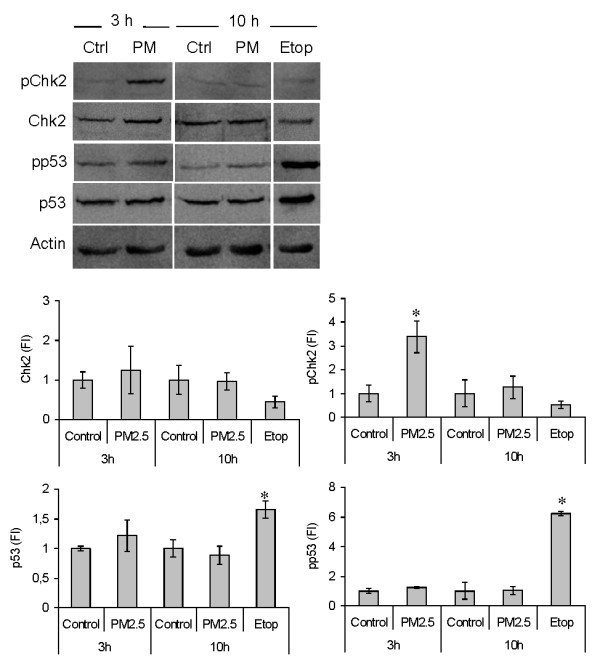
Cell cycle control proteins expression. The expression of p53/pp53 and Chk2/pChk2, proteins possibly involved in G2 checkpoint, was measured by Western blotting in BEAS-2B cells exposed for 3 and 10 h to 7.5 μg/cm2 of winter PM2.5. The topoisomerase II inhibitor etoposide (Etop, 250 nM, 10 h exposure) was used as positive control for p53/pp53. Representative images of the Western blotting are shown and the results of 3 independent experiments are reported in the histograms as fold increase (FI) over the control values (mean ± SEM). *Statistically significant difference from untreated cells (control), P < 0.05.